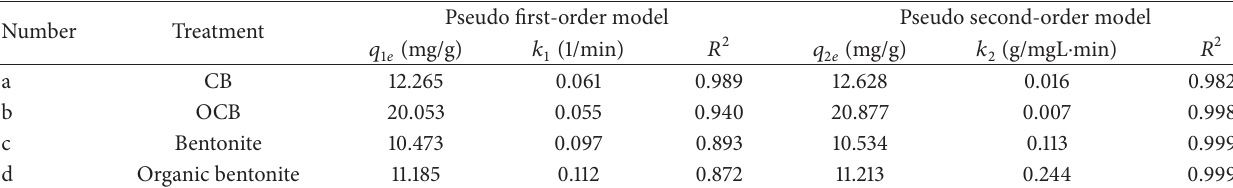
Table 2: Parameters of adsorption kinetics model of Cu(II) on CB and bentonite.